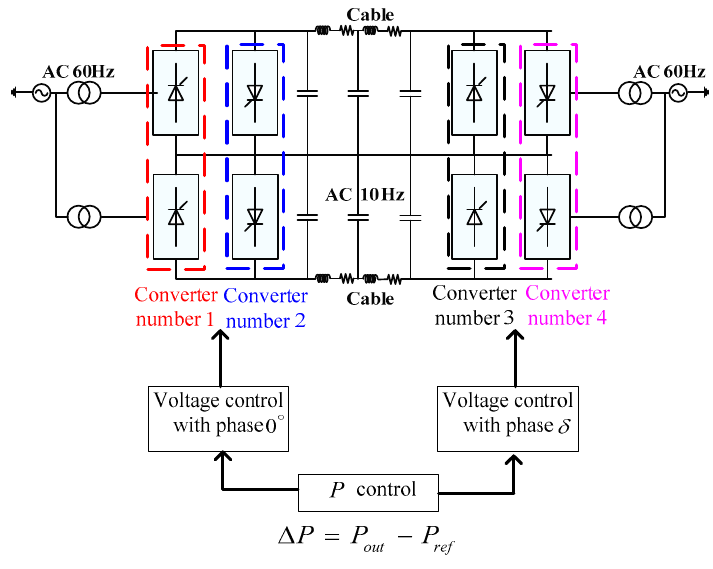
Figure 12. Layout of control system for LFAC system.